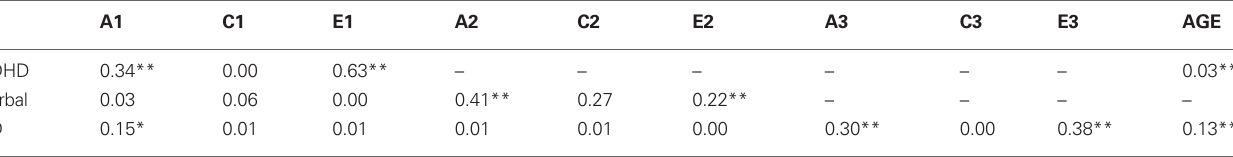
Table 4 | Percent variance of ADHD, verbal ability, and CD.